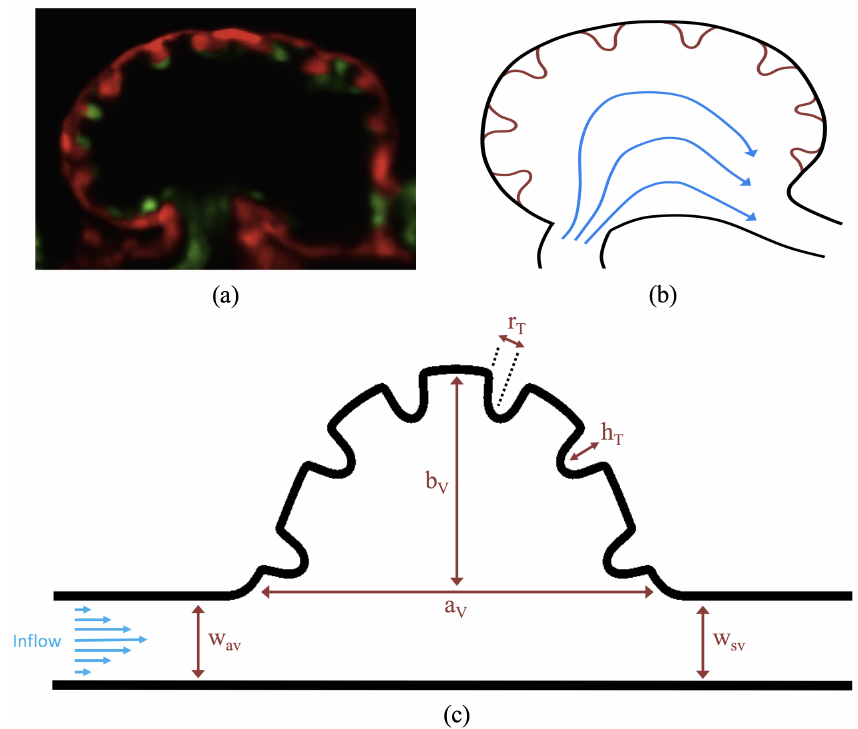
Figure 3. ( a ) a microscopy image of an embryonic zebrafish’s trabeculated ventricle at 4 dpf from Liu et al. [21]. This snapshot was taken immediately before the systolic phase. The protrusions into the ventricle are trabeculae. The image was taken from Tg(cmlc2:dsRed)s879; Tg(flk1:mcherry)s843 embryos expressing fluorescent proteins that label the myocardium and endocardium, respectively [21]; ( b ) simplified diagram showing the basic idea behind our idealized geometry. Blood flows from the atrio-ventricular canal into the ventricle and then proceeds into the bulbus arteriosus; ( c ) further idealization of the computational model which is now flattened. The geometric parameters are as follows: a V and b V are the semi-major and semi-minor axis of the elliptical chamber, h T and r T are the height and radii of the trabeculae, and w AV and w SV are the widths of the atrioventricular (AV) canal and sinus venosus, respectively.